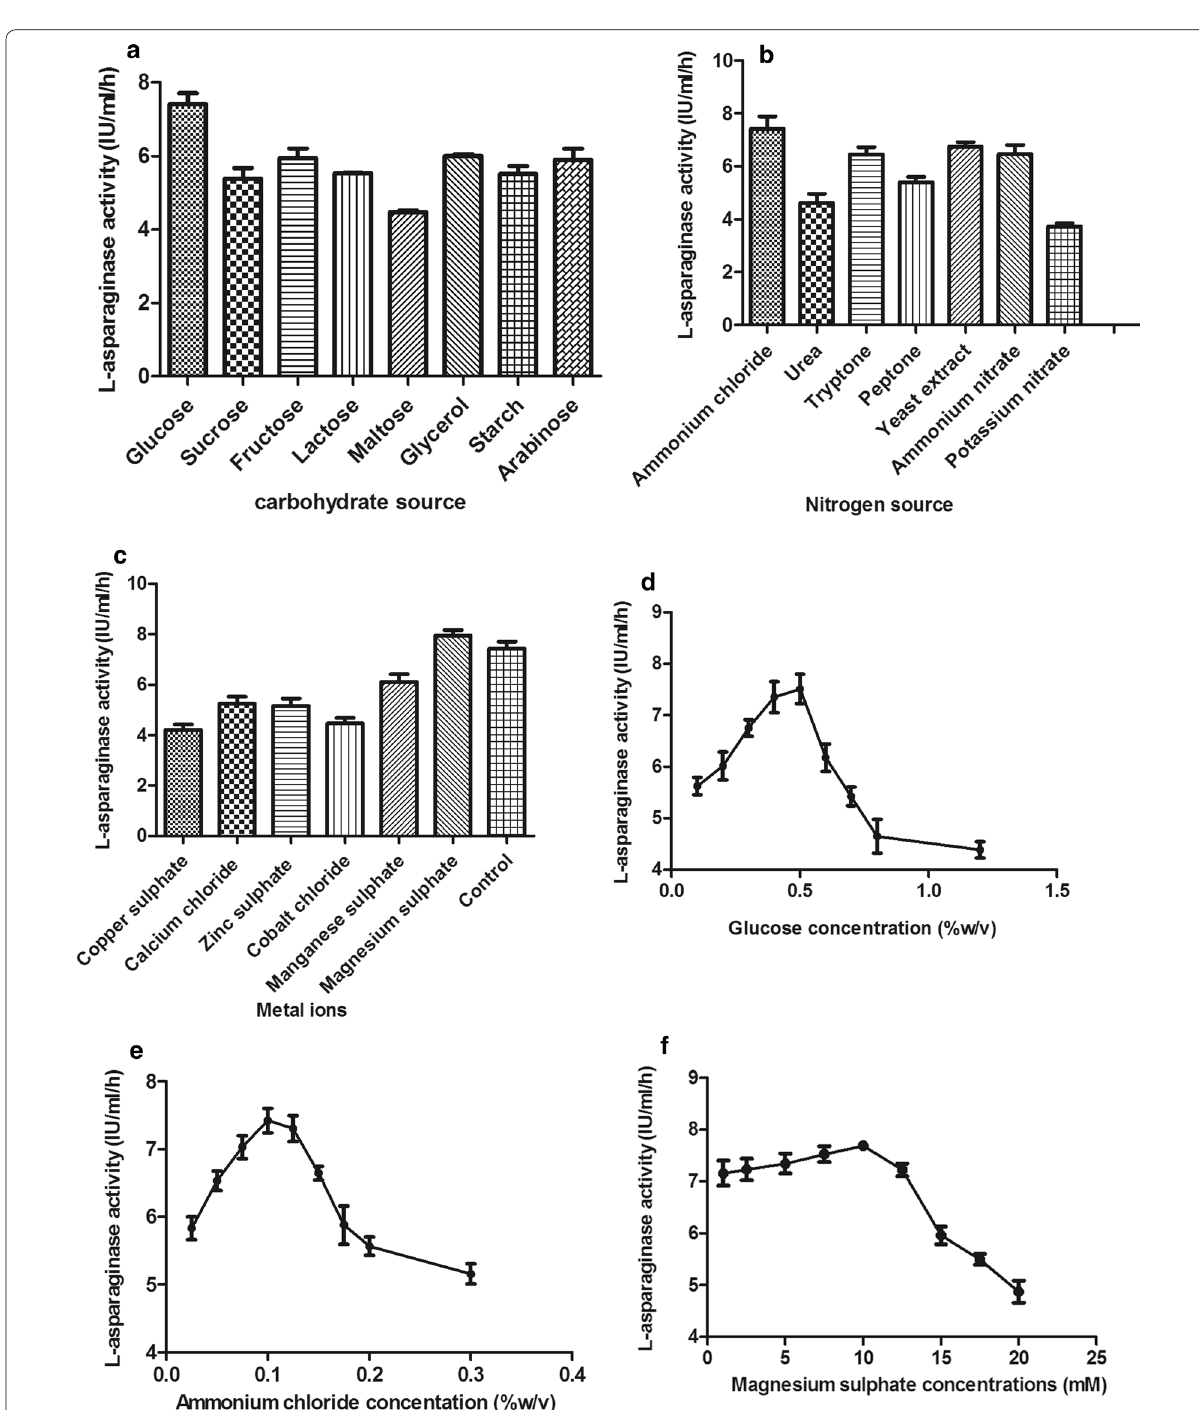
Fig. 7 Effect of different carbon sources ( a ), nitrogen sources ( b ), metal ions ( c ) and different concentrations of glucose ( d ), ammonium chloride ( e ) and magnesium sulphate ( f ) on l -asparaginase production by Bacillus licheniformis mutant strain. The enzyme productivity was expressed in terms of catalytic